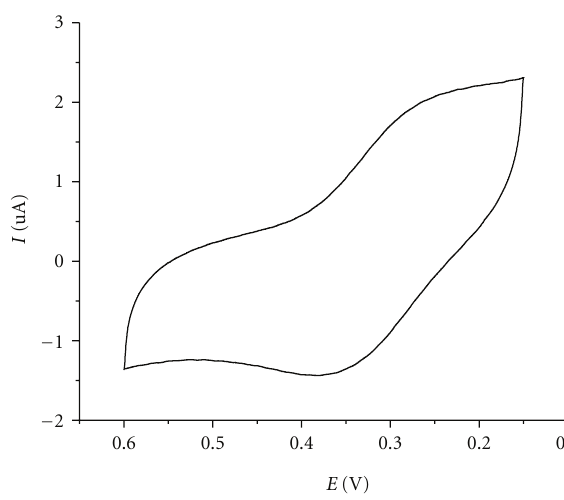
Figure 1: Cyclic voltammogram of the Cu(II) complex recorded with a platinum electrode in DMF solution containing ( n-